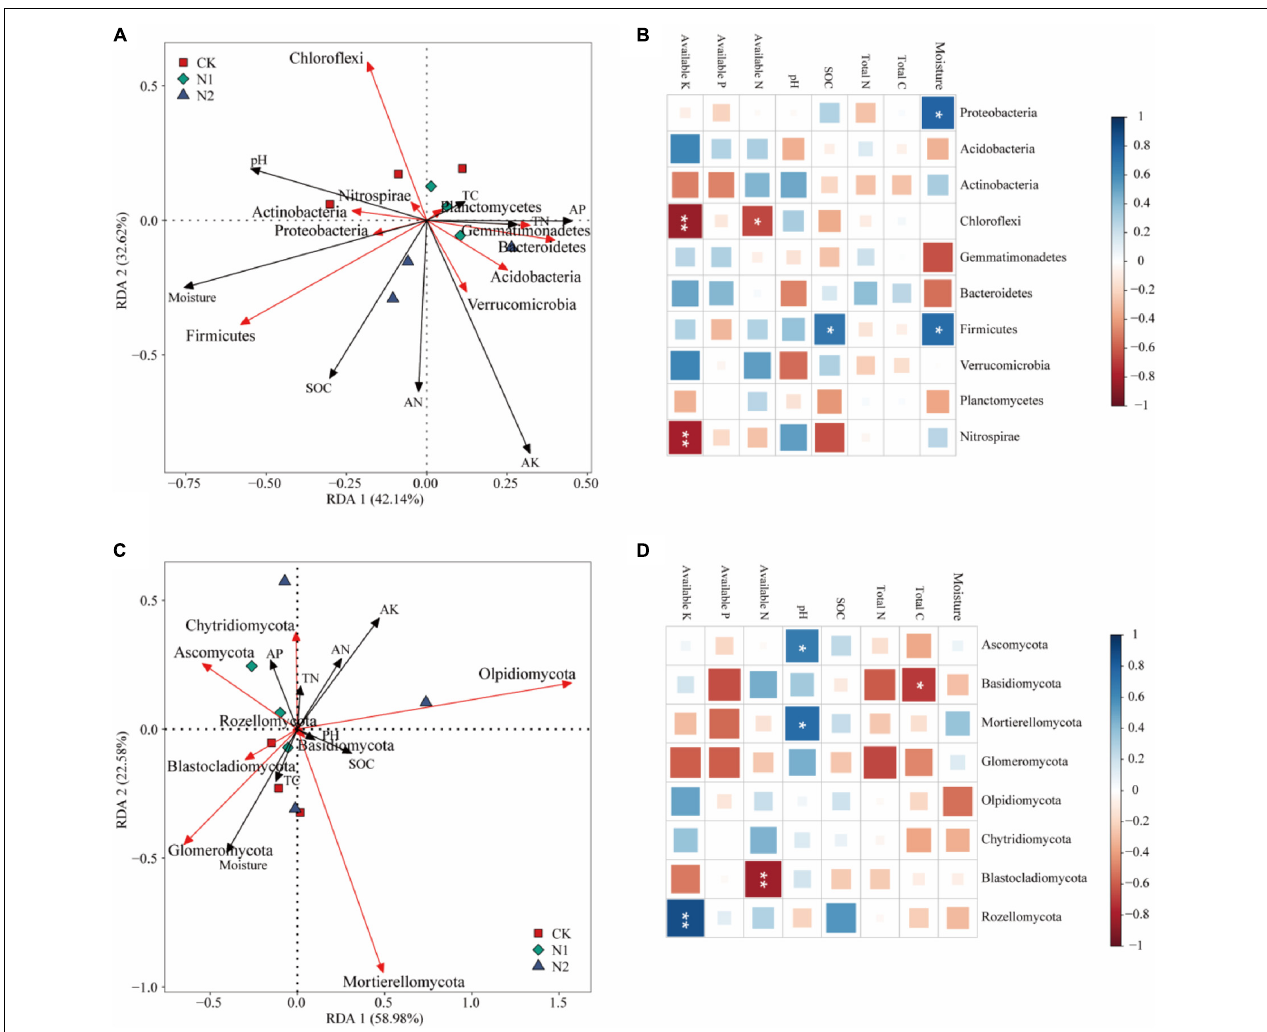
FIGURE 7 | Effects of soil chemical properties on structure and function of soil microbial community after N application. (A) Redundancy analysis of bacterial community structure and soil properties. Red arrows indicate soil bacteria, and black arrows indicate soil chemical properties (length = level). (B) Correlation between bacterial community (phylum) and soil chemical properties. * P < 0.05, ** P < 0.01. (C) Redundancy analysis of fungal community structure and soil properties. Red arrows indicate soil fungi, and black arrows indicate soil chemical properties (length = level). (D) Correlation between fungal community (phylum) and soil chemical properties. * P < 0.05, ** P <